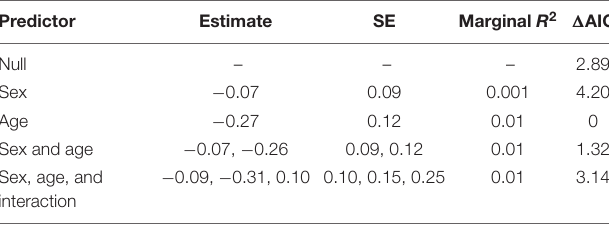
Figure 1 ) for individual moose varied between different age-classes (yearling and adult) and sex (bulls and cows) for a population in Isle Royale National Park over a 19-year period (2001–2019).